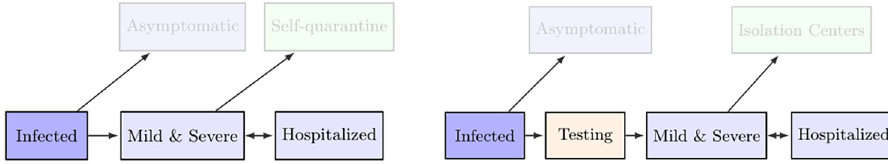
Fig 5. Isolation center scenarios. Left: Home-based care scenario where mild and severely symptomatic PoCs self- quarantine in their shelters up to a compliance factor. Right: Scenario where mild or severely symptomatic individuals go to isolation centers up to a compliance